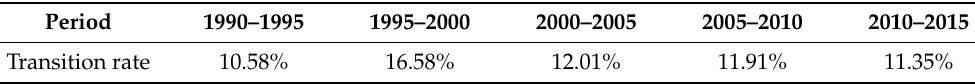
Table 23. Table of transfer rate of each time period in the overall landscape.